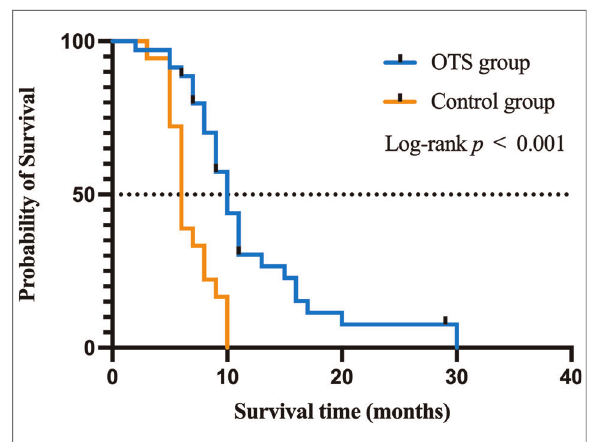
FIGURE 5 The impact of orthopedic therapeutic surgery and conservative treatment on the survival of patients after bone metastasis.